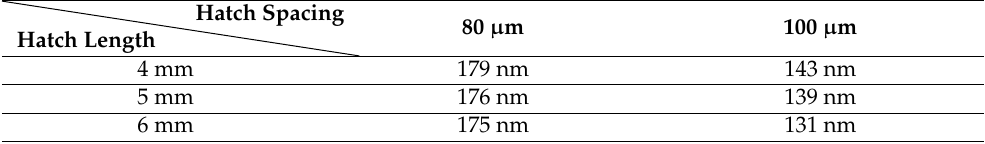
Table 3. Mean crystal radius in control